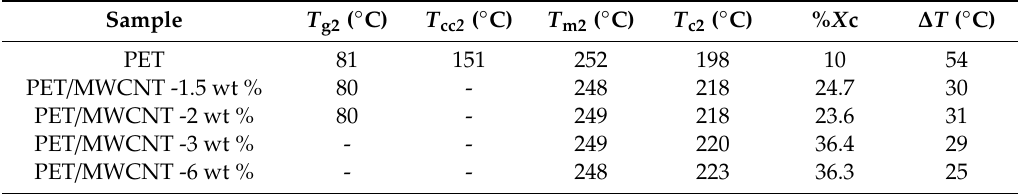
Figure 1. Differential scanning calorimetry (DSC) thermograms showing: ( a ) the second heating run, for neat polyethylene terephthalate (PET) and PET/multiwall carbon nanotubes (MWCNT) composites and ( b ) the crystallization exotherms from the melt/cooling cycle from 300 to 25 °C. Table 1. E ff ect of MWCNT addition on thermal parameters for PET and PET / MWCNTs